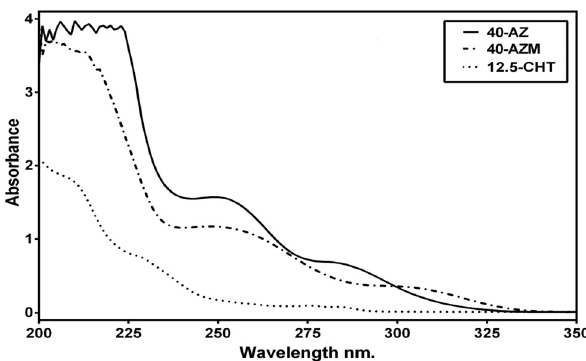
Figure 2: The absorption spectra of AZM 40 μ g mL − 1 ( _._._ ) ,